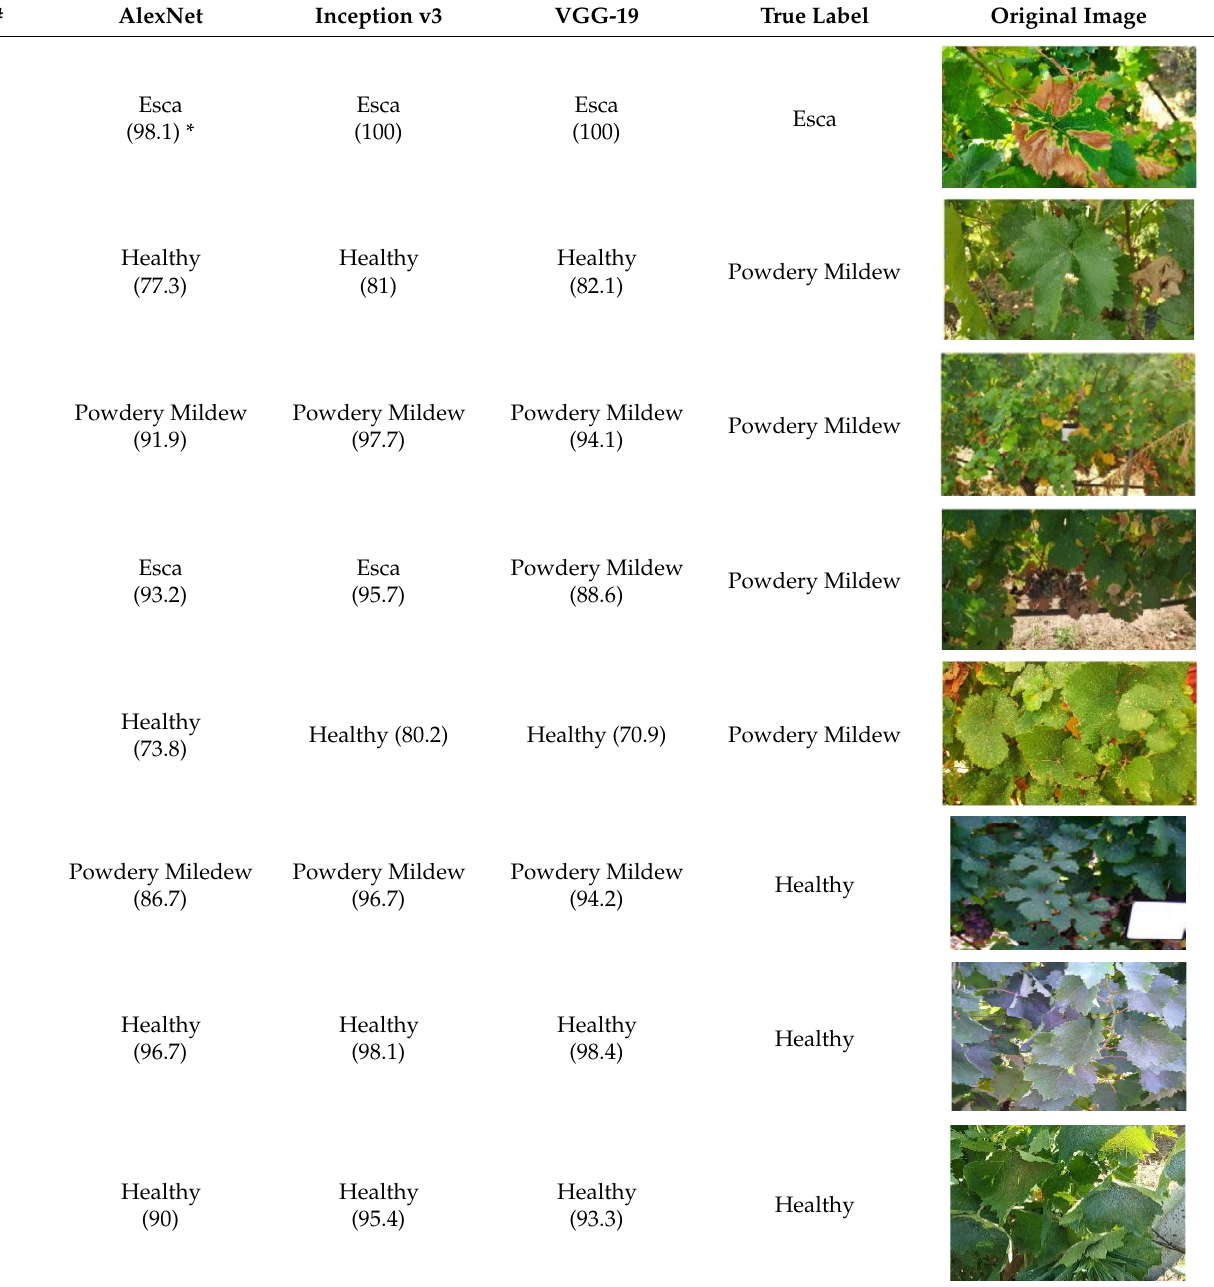
Table 13. AlexNet, Inception v3, and VGG-19 trained with fine-tuning and a three-layer neural network in the last FC layer. Model evaluation (testing phase) gives examples of untrained images from Chatzivariti’s vineyard dataset.